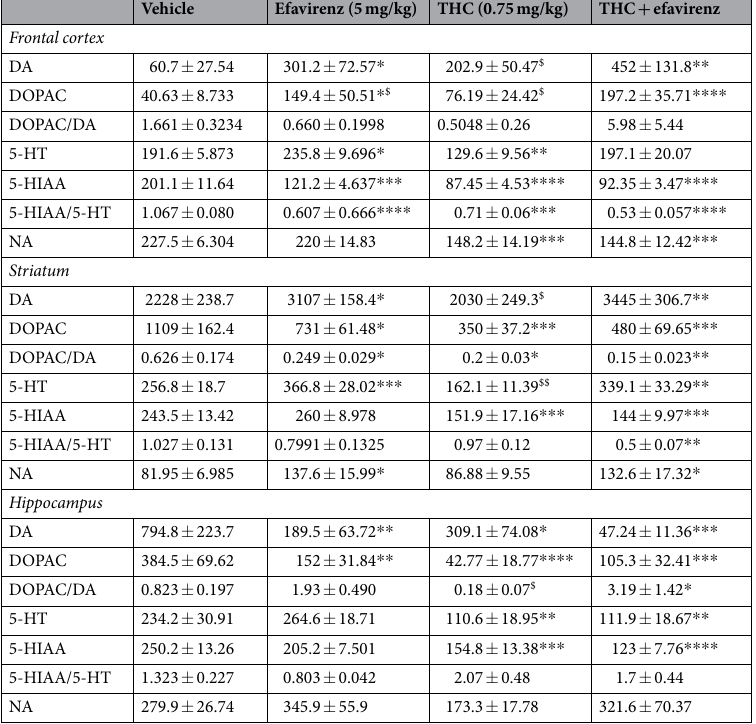
Table 1. Selected monoamine levels (ng/mg tissue) in regional brain tissue of rats exposed to sub-chronic vehicle (n = 24), efavirenz (5 mg/kg) (n = 12), THC (0.75 mg/kg) (n = 12) and THC + efavirenz respectively. Presented as Mean ± standard error of the mean (SEM). DA, Dopamine; DOPAC, 3,4-Dihydroxyphenylacetic acid (DOPAC); 5-HT, Serotonin; 5-Hydroxyindoleacetic acid (5-HIAA), NA, Noradrenaline. * p < 0.05, ** p < 0.01 vs Vehicle; $ p < 0.05, $$ p < 0.01 vs THC + efavirenz (One-way ANOVA, Bonferronni post-hoc